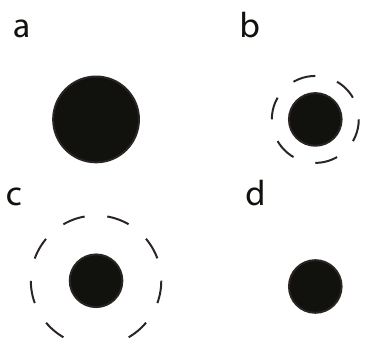
Figure 1 . A process in which a black hole changes its state. Initially, the black hole is in the state a. Then it emits (for simplicity) a spherically symmetric wave, and the system changes its state to b. The dashed line represents emitted matter or field. The emitted matter keeps moving away from the black hole and the system changes its state to c. The matter completely escapes from a black hole and the state becomes d. This represents an emission process ( a → b → c → d ). An absorption process can be made by reversing the order of steps ( d → c → b → a ).